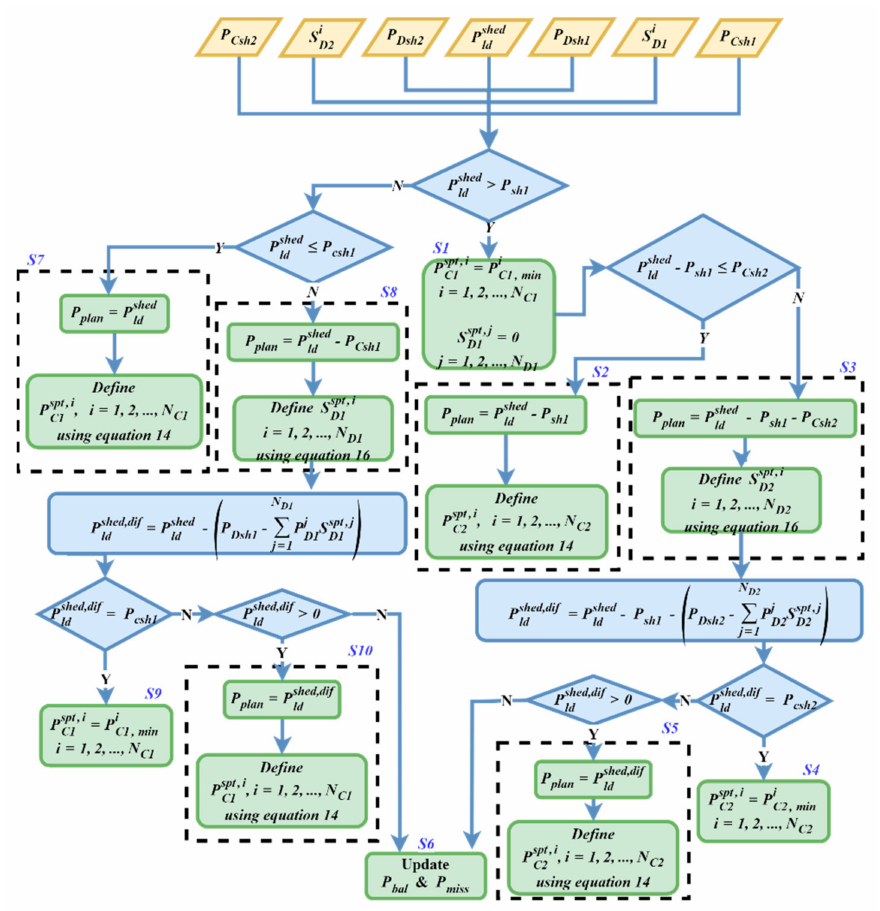
Figure 10. Flow chart of the load shedding